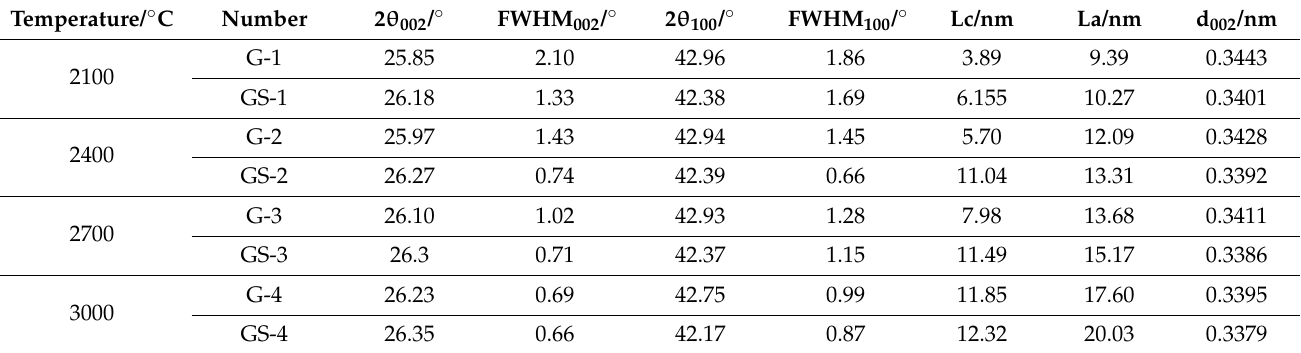
Table 3. XRD parameters of experimental